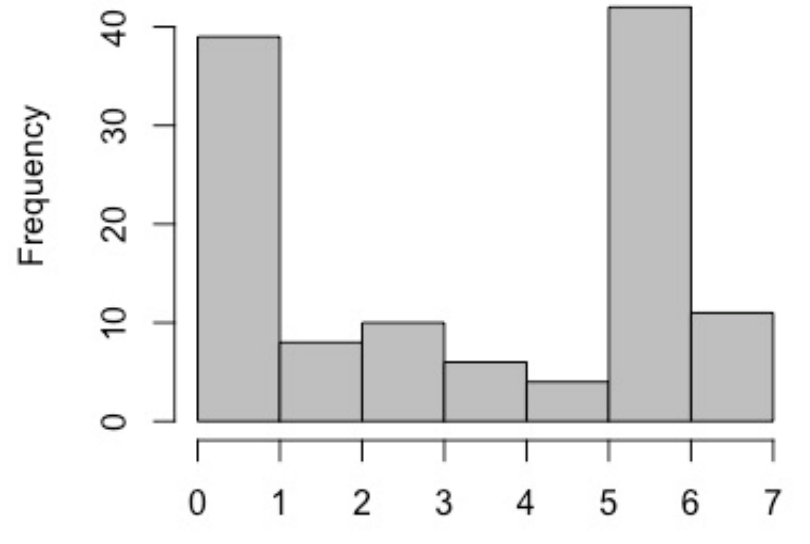
Figure 1. Histogram of the total amount of second language exposure in years for the overall sample (N = 120).